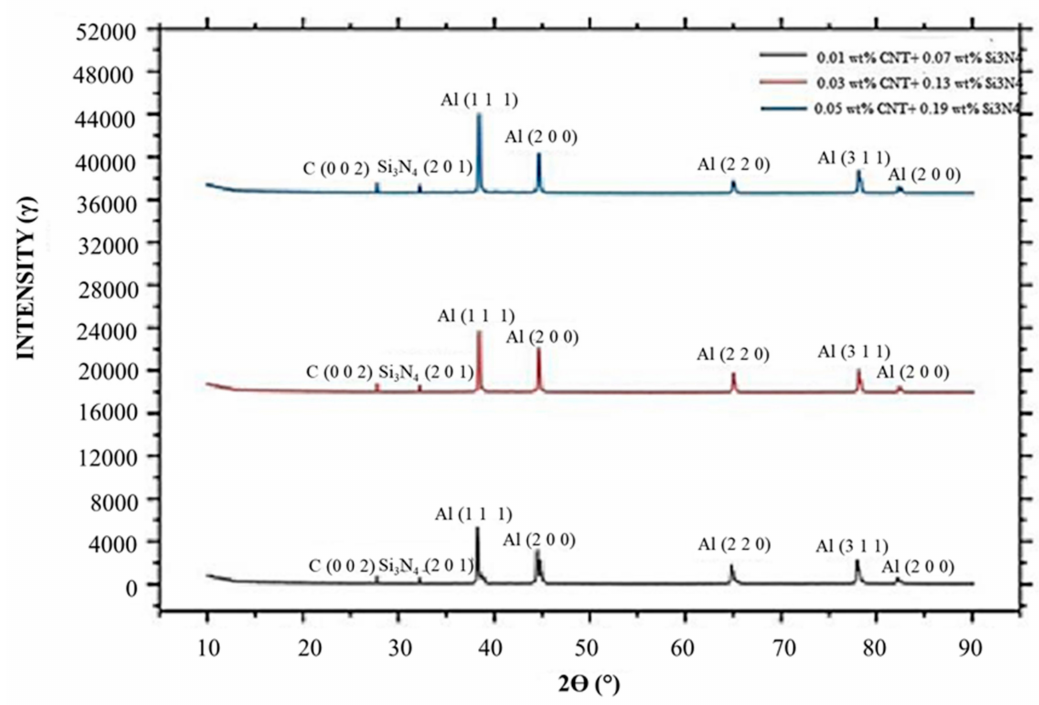
Figure 12. The 2 θ X-ray di ff raction (XRD) scan of FWTPET + FSP specimens with di ff erent reinforcement volumes of CNT and Si 3 N 4